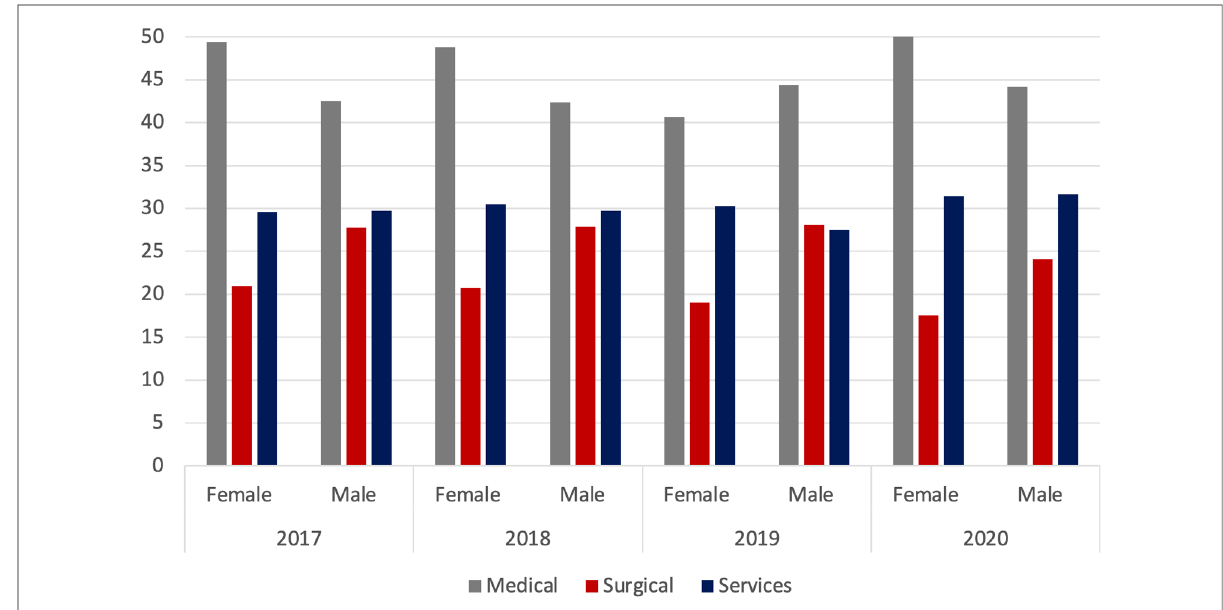
FIGURE 2 Gender distribution among the three areas in percentage: medical, surgical,